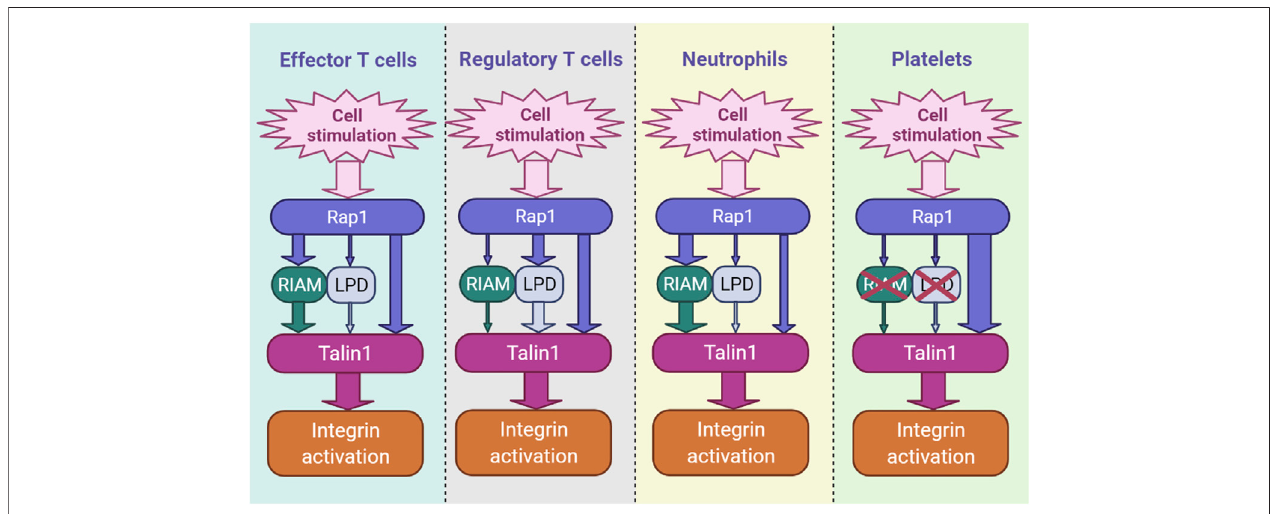
FIGURE 1 | The hierarchy of integrin activation pathways differs by cell type. RIAM- and LPD-dependent pathways and the direct binding of Rap1 to talin1 coexist and contribute in parallel in blood cells, including immune cells. The thickness of the arrow indicates the relative importance of each channel.